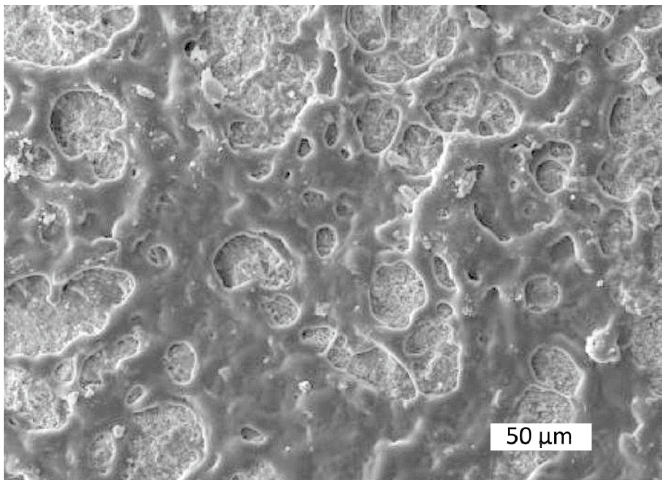
Figure 25. Lime/sand paste tests. ( A ) Mixing lime and sand. ( B – D ) Lime paste used to fill open fractures in Tak fossil wood. Natural or commercial pigments can be used to tint the mixture to provide an approximate color match.